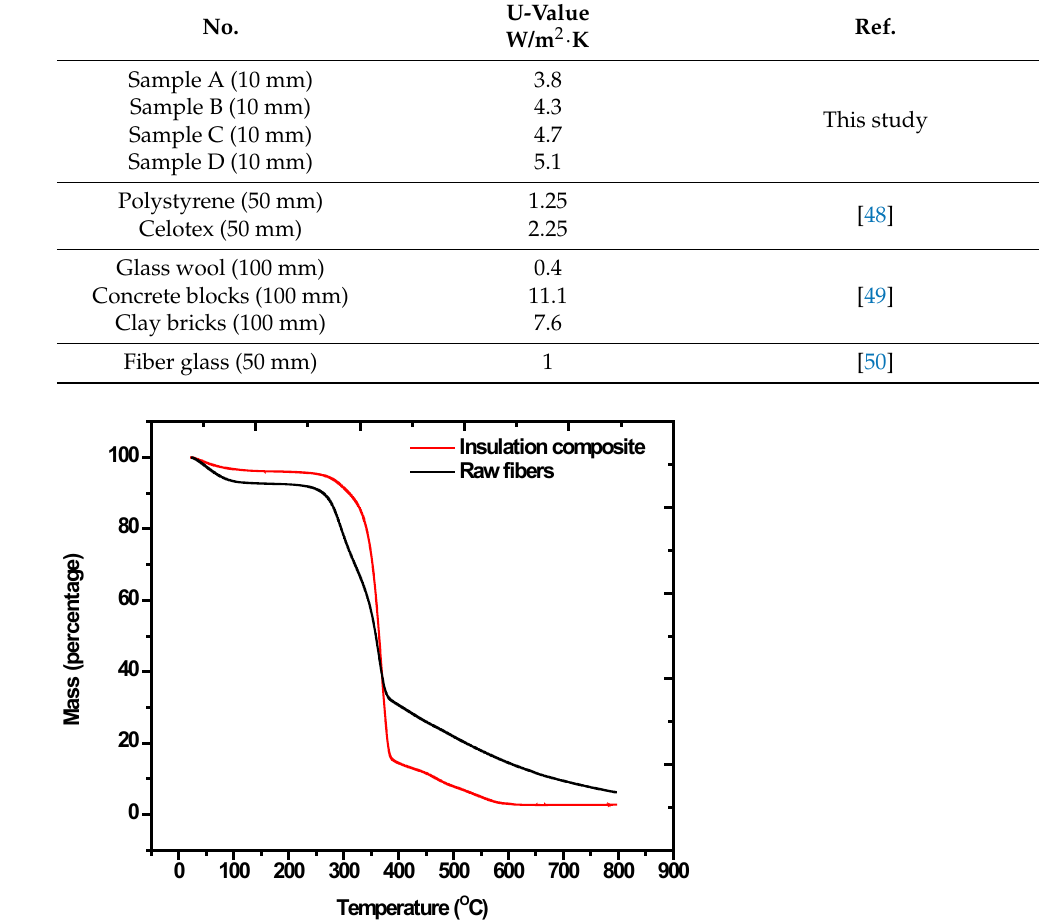
Table 4. U-value of insulation materials.